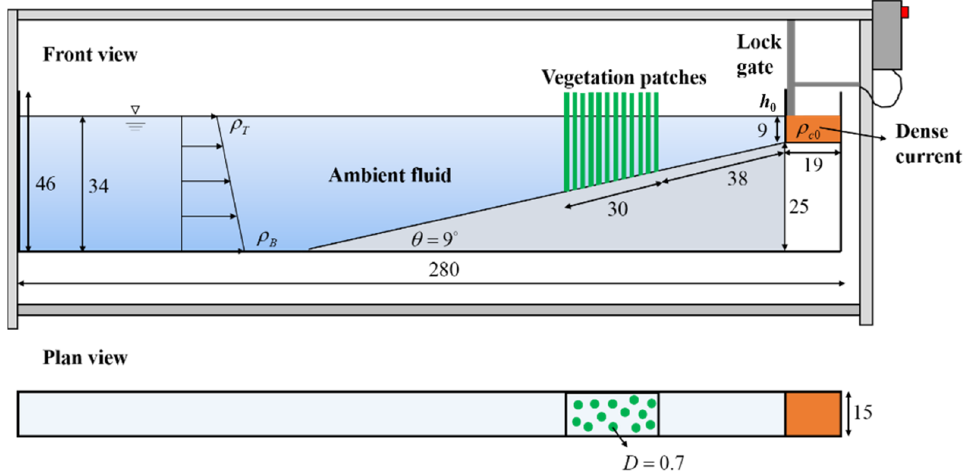
Figure 1. The schematic of the experimental setup (unit: cm).